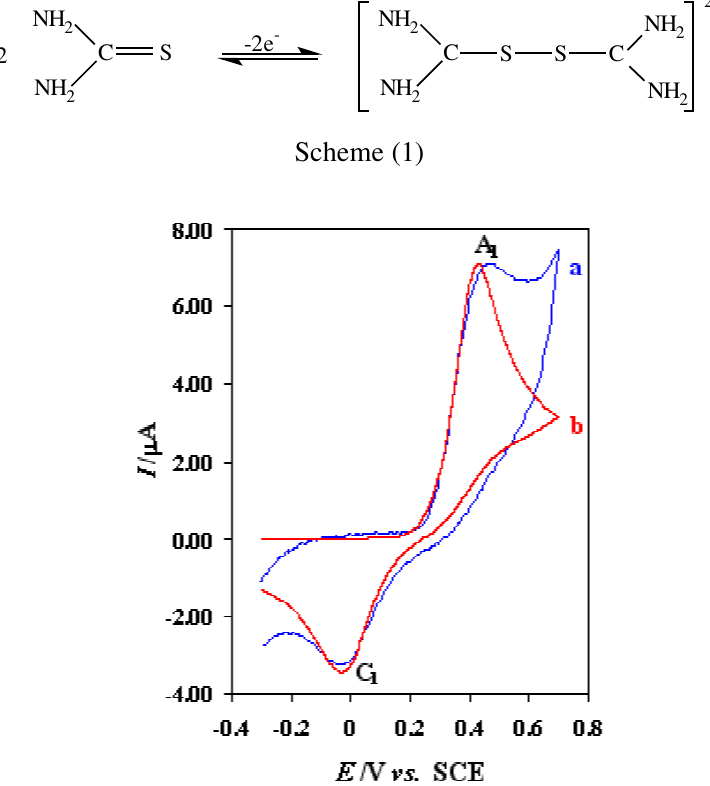
Figure 1. Experimental (curve a) and simulated (curve b) cyclic voltammograms of thiourea at bare Pt electrode in acetate buffer solution (C = 0.15 M, pH = 4.5). Scan rate, 50 mV/s. Thiourea concentration, 0.75